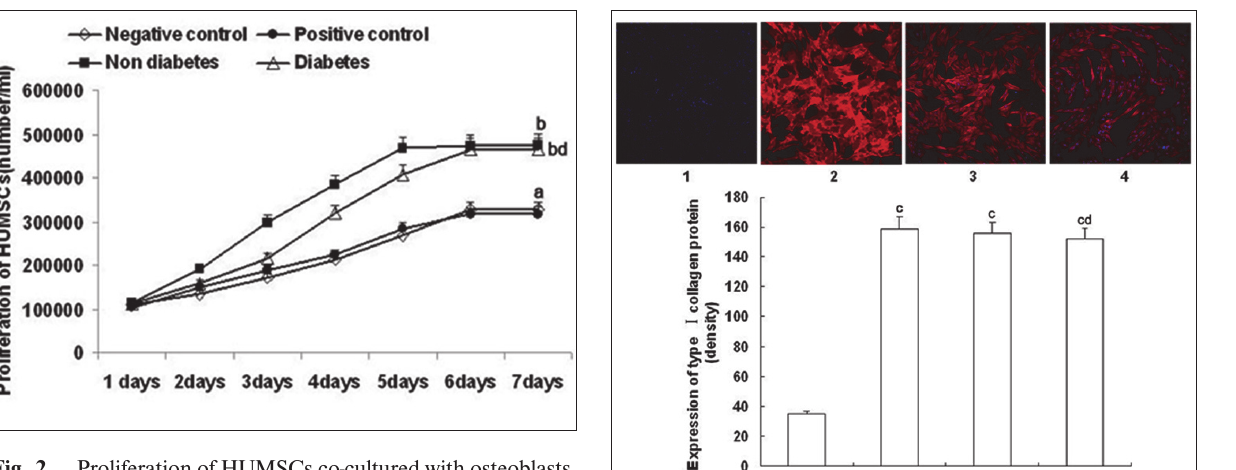
Fig. 2. Proliferation of HUMSCs co-cultured with osteoblasts. a P >0.05, b P <0.05 vs. negative control group d P >0.05 vs. non-dia- betic group. bright red fluorescence, cell nuclear staining with Hoechst